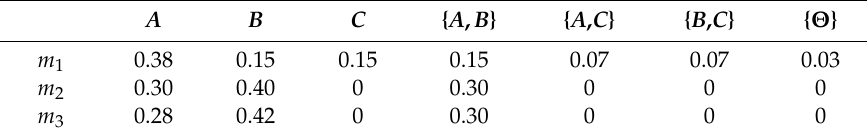
Table 3. Basic probability distribution of multi-sensor